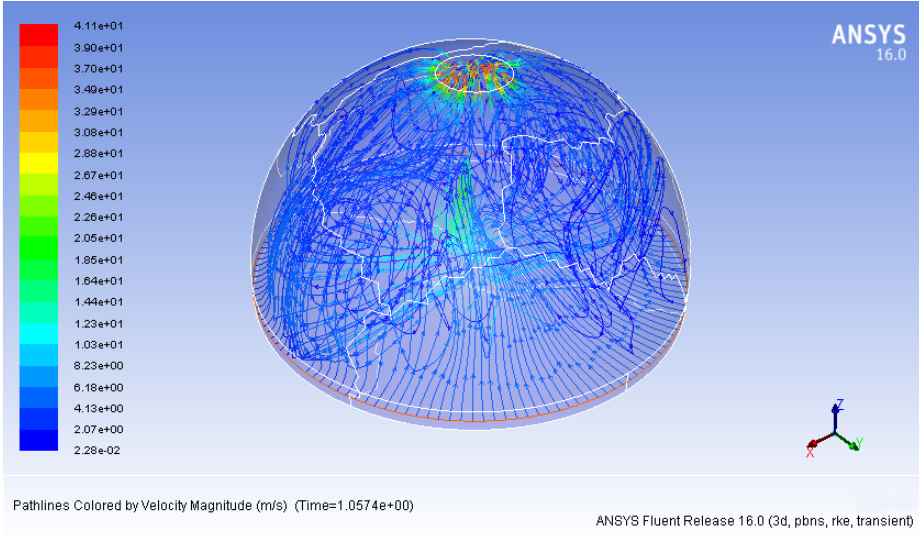
Figure 17. Gas traces flowing over the auxiliary line.